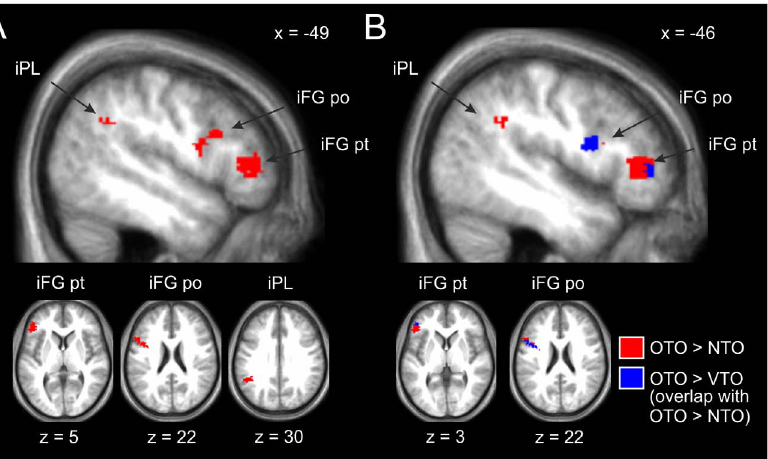
To confirm the specific involvement of a fronto-parietal network of brain regions by OTO after training, SVC was applied at brain regions hypothesized to be involved in action observation and